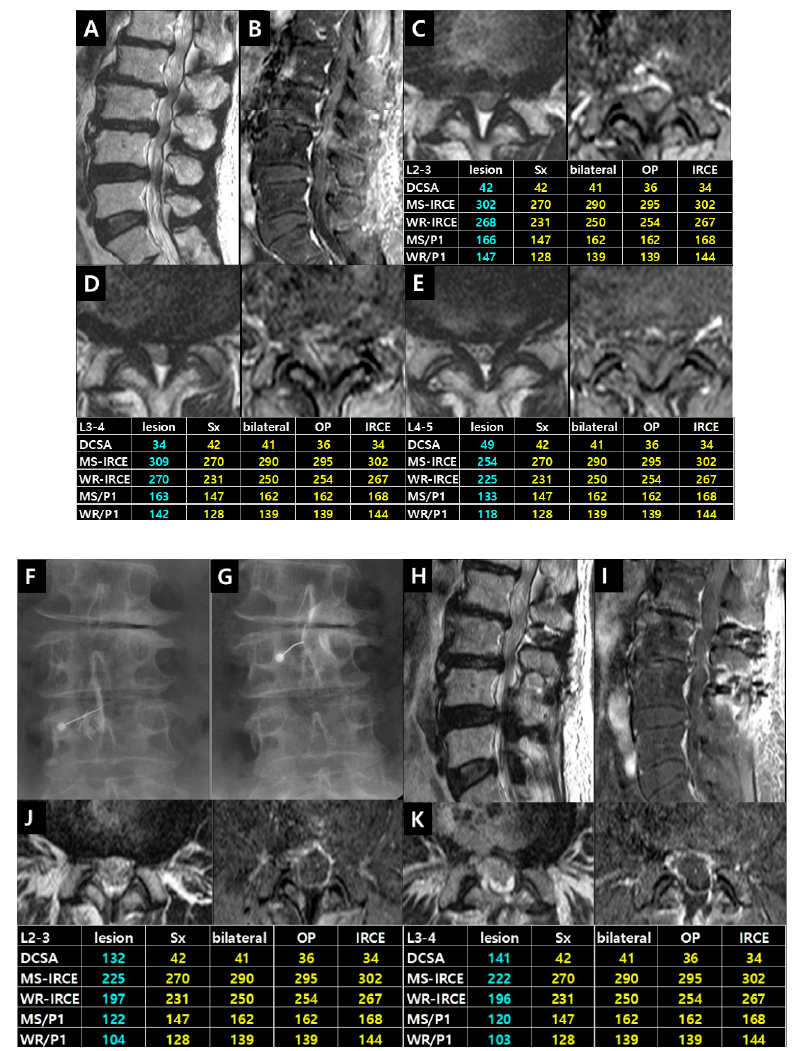
Figure 11. Illustrative Case 3. ( A , B ) T2-weighted and enhanced fat-suppressed T1-weighted sagittal